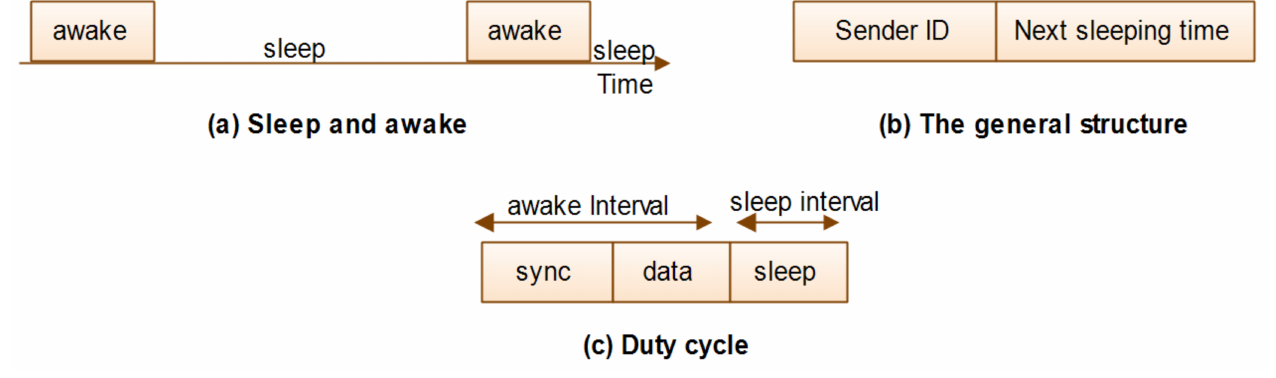
Figure 4. The S‑MAC protocol.